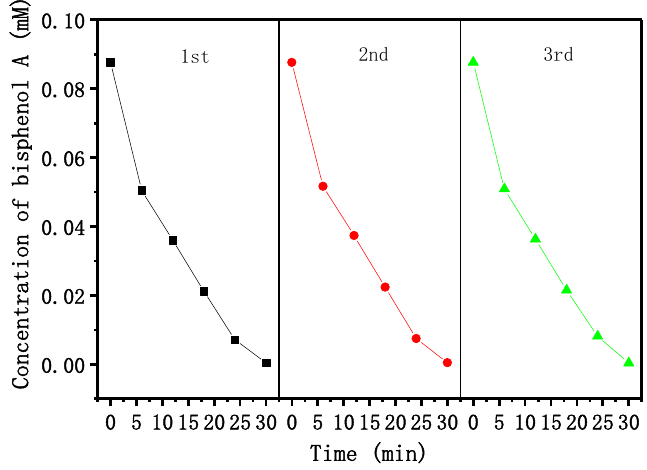
Figure 18. Concentration variation curves of bisphenol A during photocatalytic degradation of bisphenol A in pharmaceutical wastewater with Ag 3 PO 4 /Gd 2 BiTaO 7 heterojunction as photocatalyst under visible light irradiation for three cycle degradation tests.